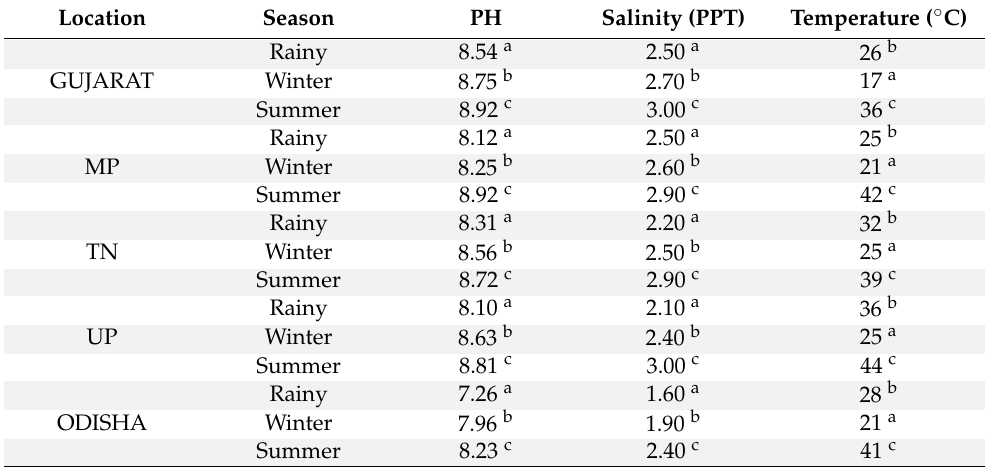
Table 2. Spatio-temporal variation of water quality parameters at different sampling